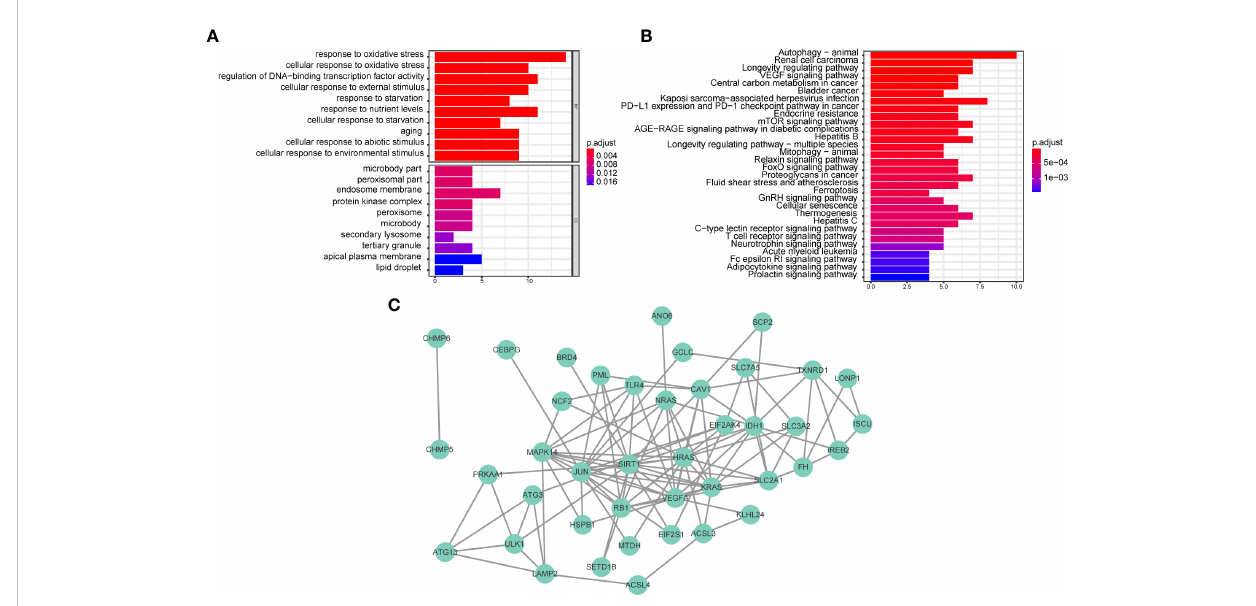
FIGURE 3 Biological functional and pathway enrichment analysis of CD8+ T cell-related ferroptosis genes. (A, B) GO and KEGG analysis on CD8+ T cell- related ferroptosis genes. (C) Network of co-expressed CD8+ T cell-related ferroptosis genes visualized by